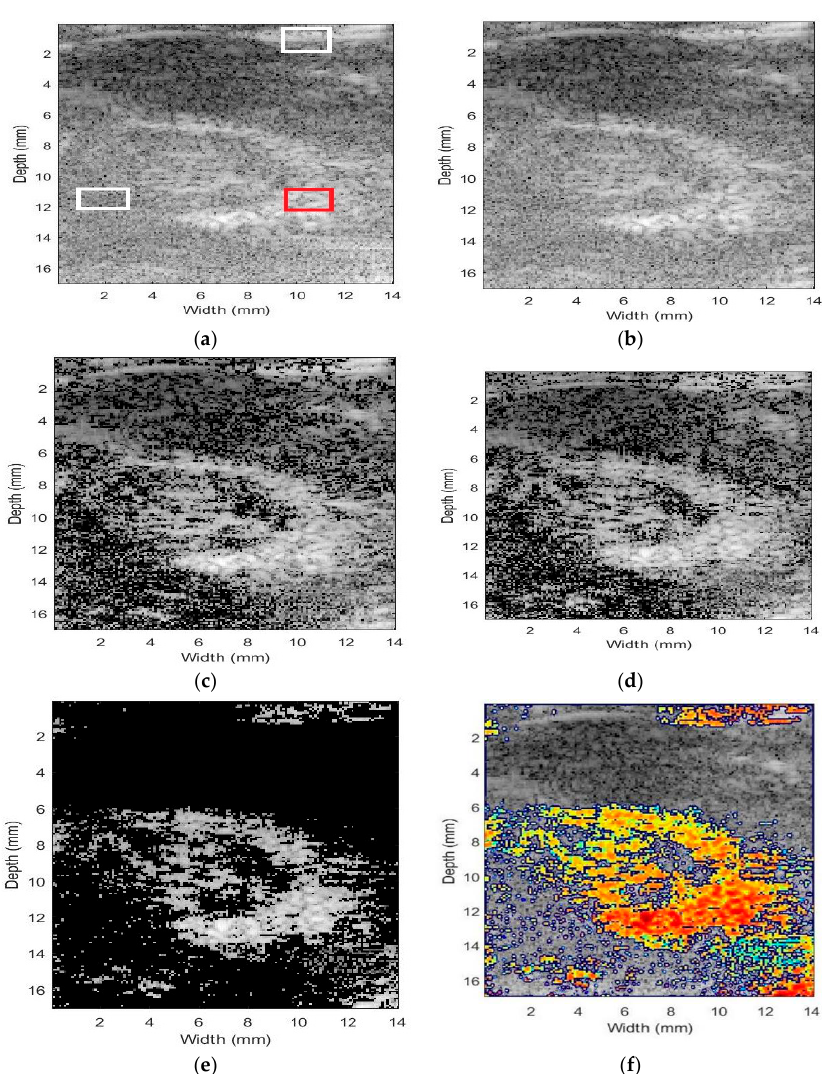
Figure 14. The image result of kidney: ( a ) DAS; ( b ) MV; ( c ) ESBMV; ( d ) BWT; ( e ) bubble region detection; and ( f ) UCA -enhanced image.